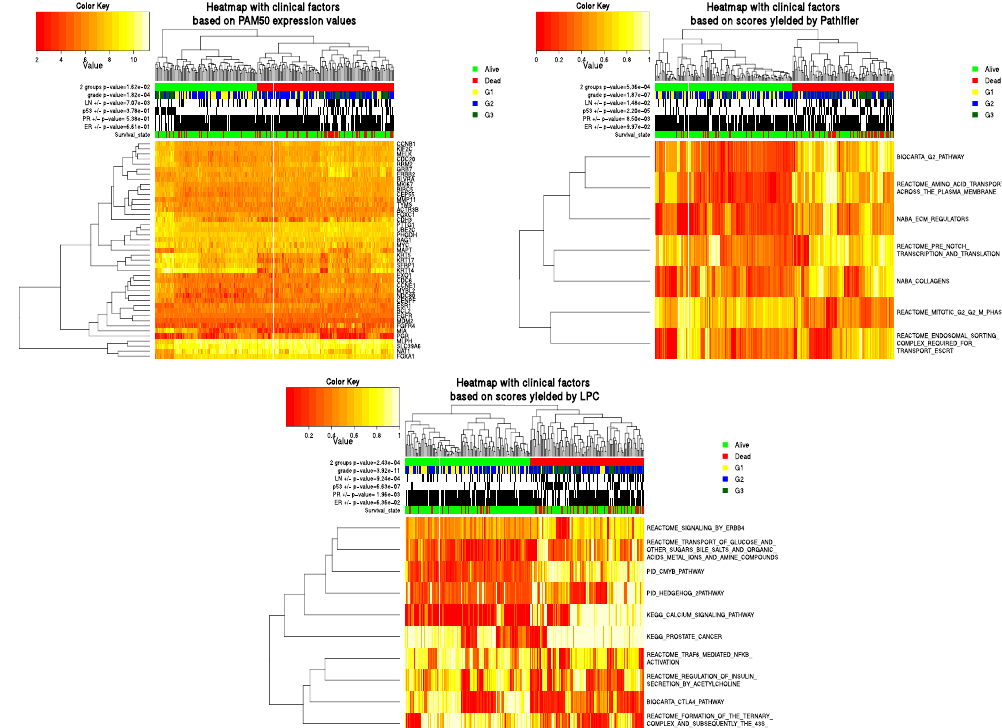
Figure 2. The comparison of the association between selected biological processes and clinical outcomes among gene-based model and biological process-based models. The samples are divided into two groups by performing the hierarchical clustering on the PAM50 gene expression matrix, PDS matrix yielded by Pathifier and BPS matrix yielded by LPC of selected biological processes, respectively. Green and red colors represent alive and dead survival status of samples respectively, White and black colors are associated with positive and negative status of ER, PR, p53 mutation, and lymph node of samples respectively. Yellow, blue and dark green colors denote different grades of samples respectively. The p-values of these clinical outcomes and dichotomized two groups with relation to survival status are calculated using Chi-square